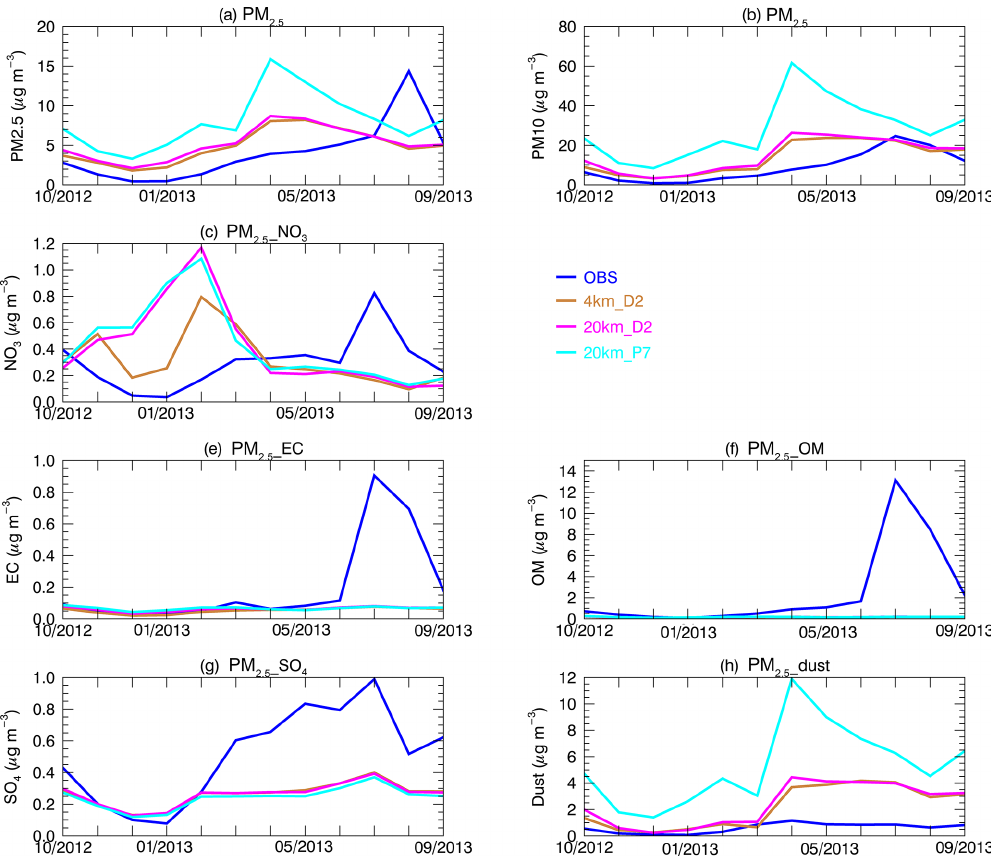
Figure 17. Aerosol mass (µgm − 3 ) for different species from IMPROVE (OBS), the 4km_D2, 20km_D2 and 20km_P7 simulations at Kaiser,